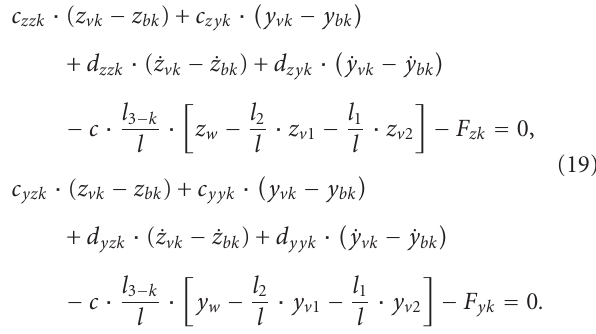
Additionally, complex coordinate systems are introduced for a subsequent mathematical